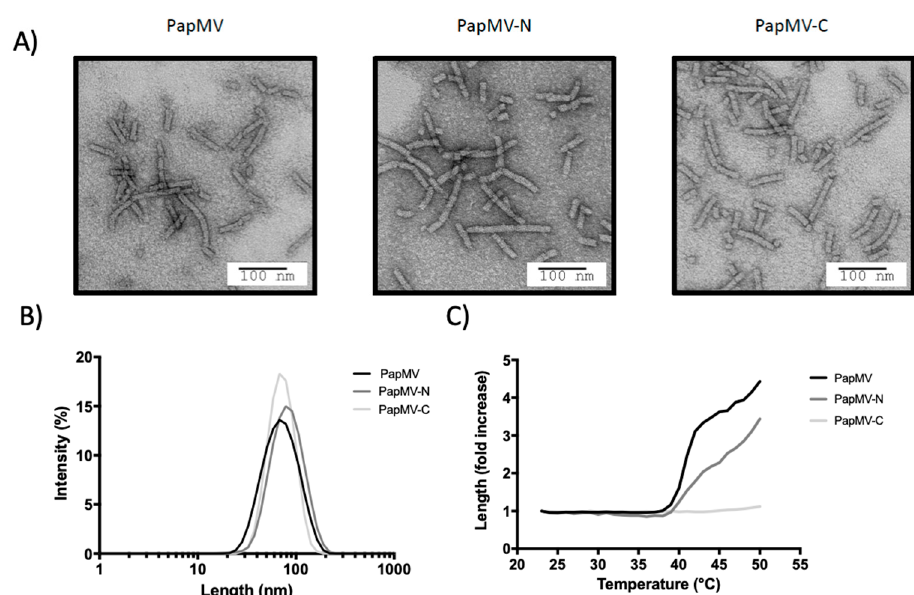
Figure 2. Characterization of PapMV, PapMV-C, and PapMV-N nanoparticles. ( A ) Electron micro- graphs of nanoparticles. ( B ) Dynamic light scattering (DLS) shows that the three types of nanoparticle have a similar average length of 70–80 nm. ( C ) The DLS was performed at increasing temperature to assess the resistance to heat denaturation of each nanoparticle.